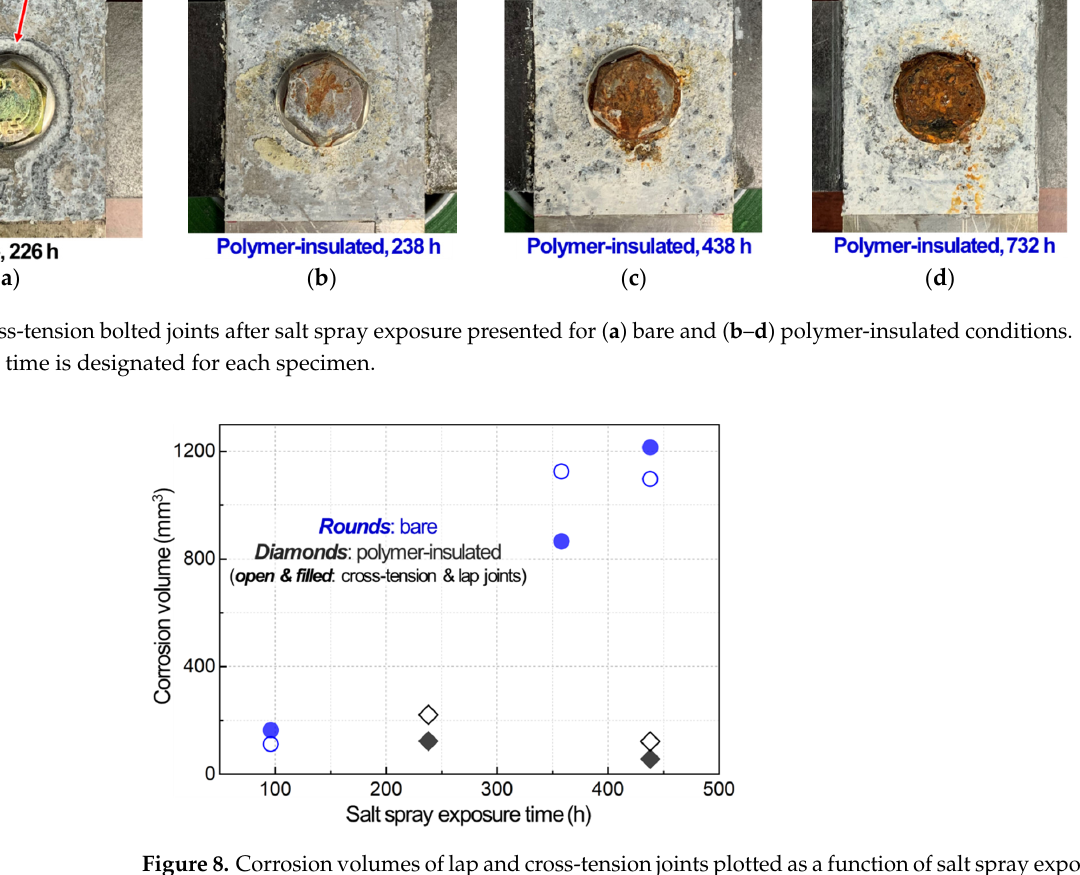
Figure 8. Corrosion volumes of lap and cross-tension joints plotted as a function of salt spray exposure time for the bare and polymer-insulated conditions. The corrosion volumes were determined by optical profilometry, as exemplified in Figure